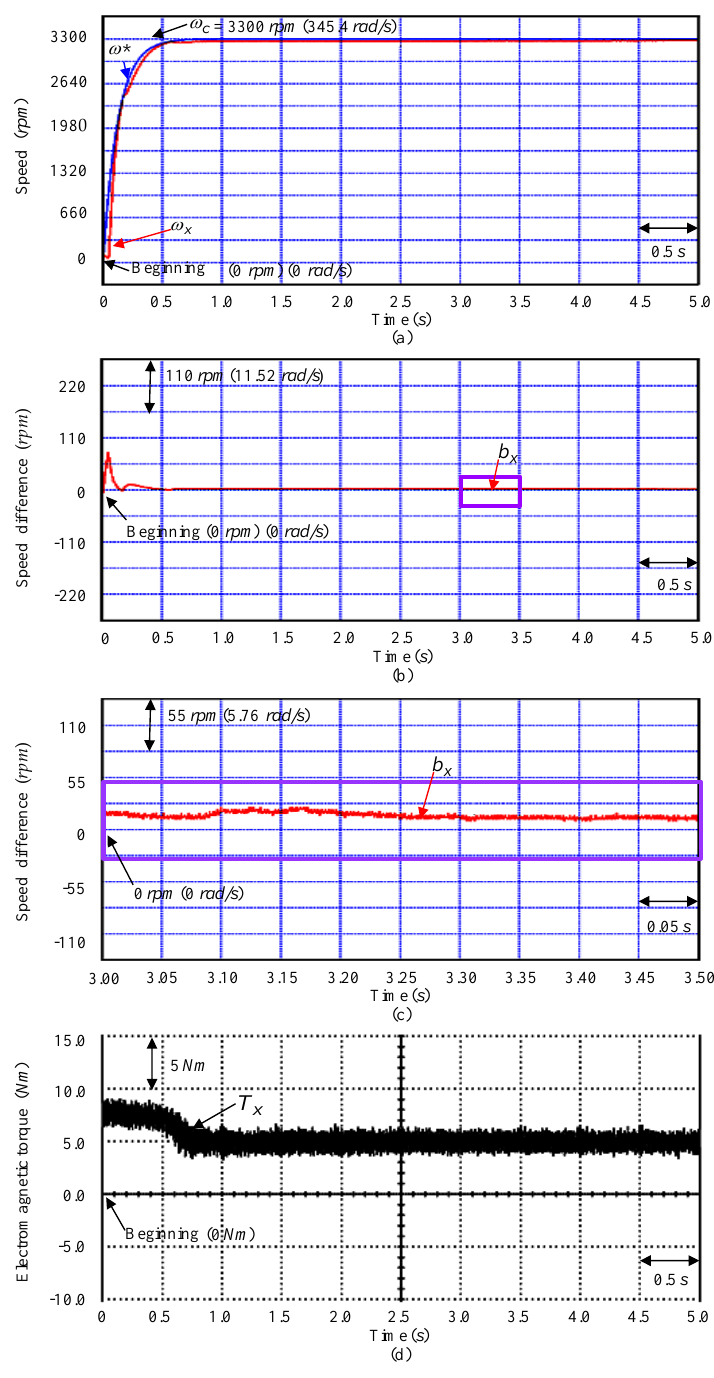
Figure 7. Tested instances with experimental results obtained by using the controller CD1 for the SSCCRIM impelled continuously variable transmission assembled system at the examination Y2 instance: ( a ) speed response, ( b ) speed difference response, ( c ) enlargement of speed difference response, ( d ) electromagnetic torque response .